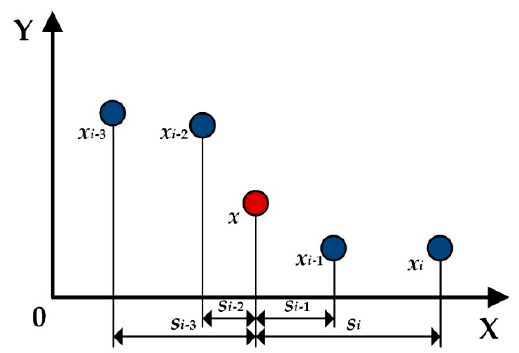
Figure 2. The definition way of weight function in the influence domain.